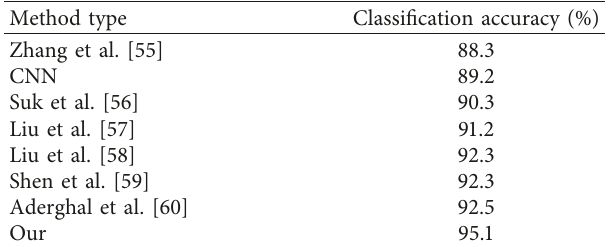
Table 6: Brain medical image classification results comparison table. Method